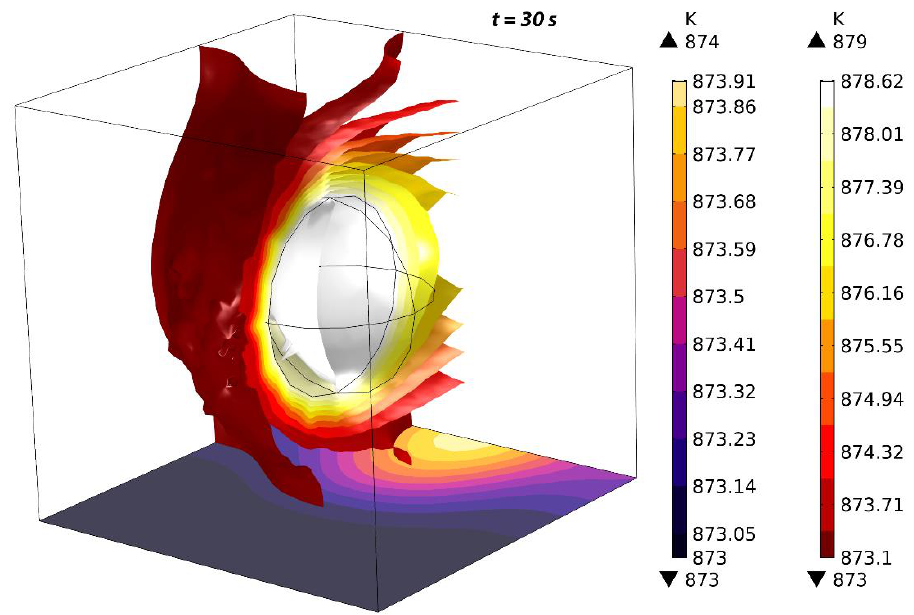
Figure 18. Change in temperature predicted by the 3D particle model at 30 s.